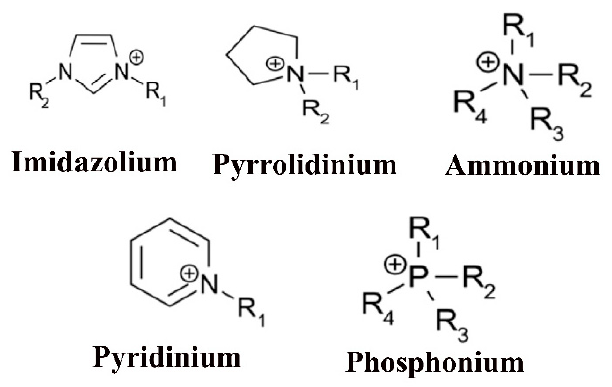
Figure 3. Different types of cations in ILs.